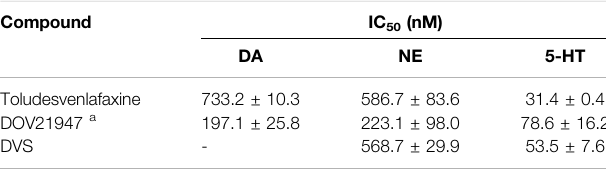
TABLE1| InhibitoryeffectsandIC 50 valuesoftoludesvenlafaxineon5-HT,NEand DA reuptake. Compound IC 50